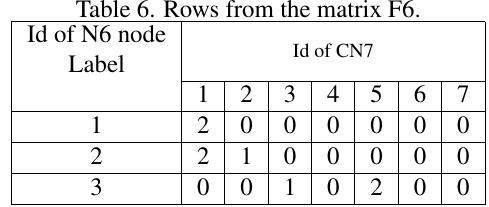
Table 6 gathers few rows from the matrix F6. Table 6. Rows from the matrix F6. Id of N6 node